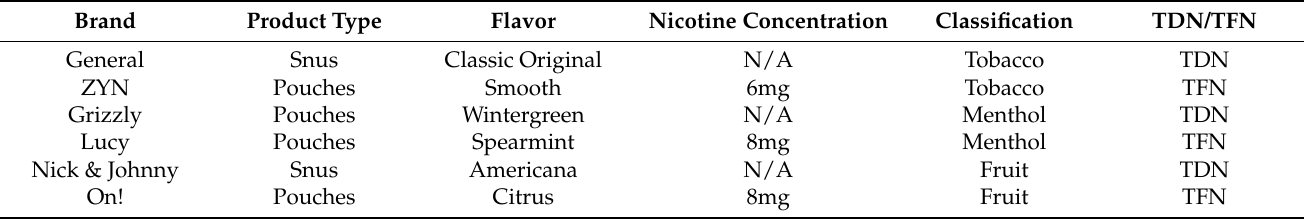
Table 1. Flavored Oral Nicotine pouches treated to Human gingival epithelium progenitors, (HGEPp) cells.